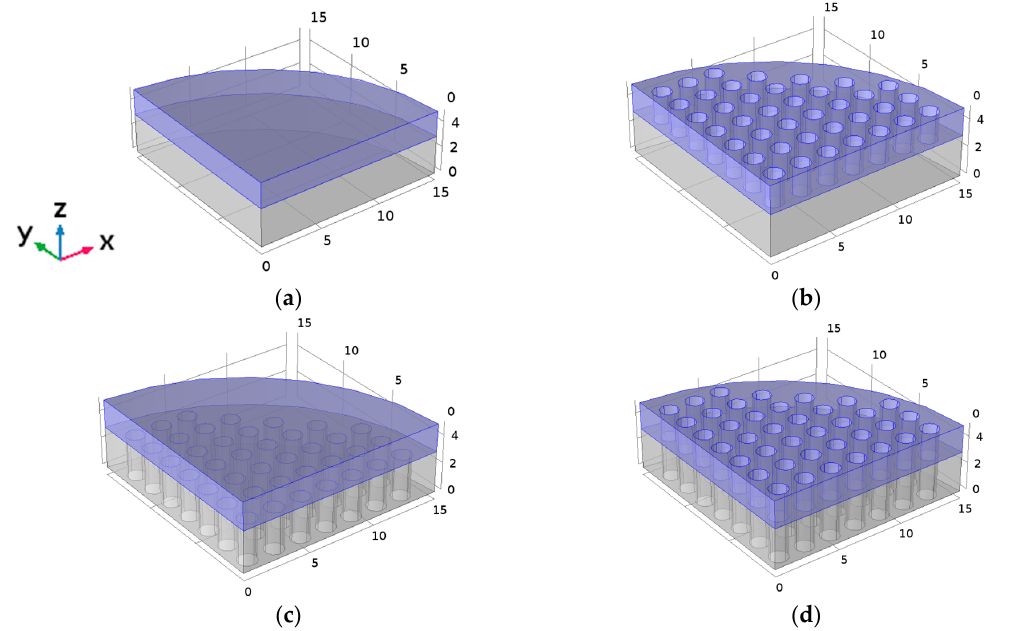
Figure 1. Geometry of the piezoelectric transducer used for the simulations. The scale is in mm; the piezoceramic PZT-4 disc is in blue and the aluminum plate in grey. ( a ) Model 1 and reference mechanical axis; ( b ) Model 2; ( c ) Model 3 and ( d ) Model 4.